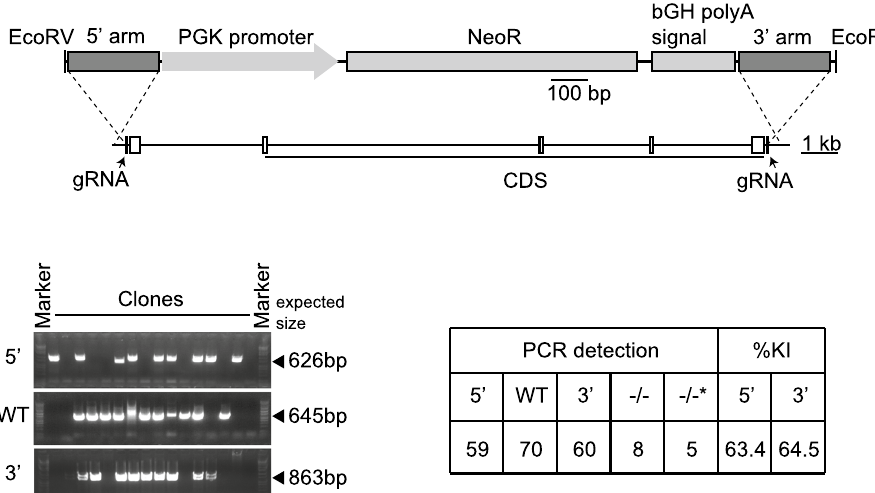
Figure 4. The homology arms improved the efficiency to knock the cassette with selection marker into the target genomic region. The schema of knockout of the target gene by pX330 plasmids and the 250 bp homology arms-flanked selection marker. Agarose gel images show the genotyping results. The table indicates the genotyping results of 93 clones. 5 ′ , 5 ′ site between the genomic region and the cassette; 3 ′ , 3 ′ site between the genomic region and the cassette; WT, wild-type allele; −/−, homozygously knockout clones: −/−*, homozygously knockout clones without the detection of 5 ′ or 3 ′ sites ligation between the genomic region and the cassette; %KI, percentage of knock-in in 93